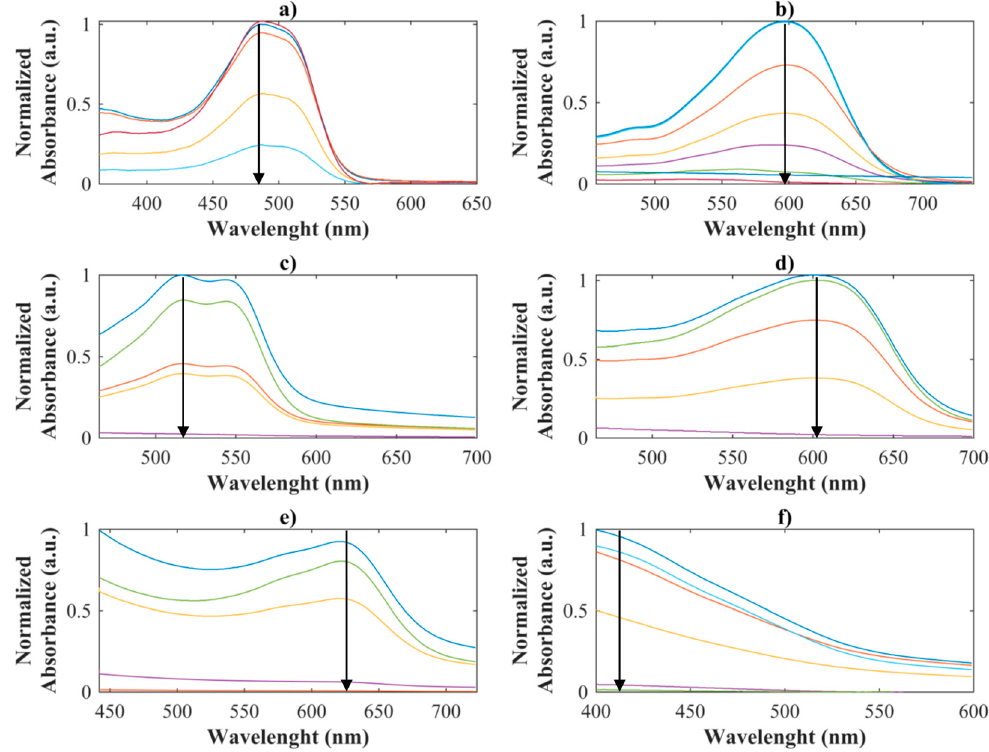
Figure 7. Absorbance of each dye by traditional method. ( a ) OP2, ( b ) RB, ( c ) PC, ( d ) PN, ( e ) PB, ( f ) PY.